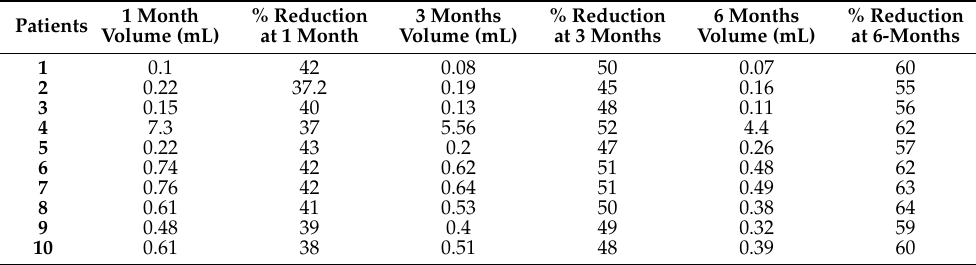
Table 3. Clinical data of volume reduction in the lymph nodes metastases treated with laser ablation.